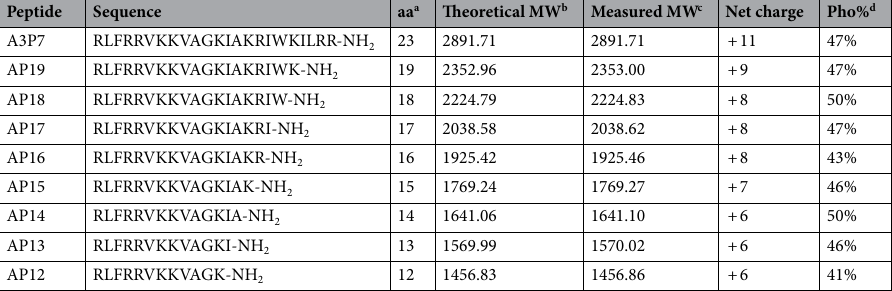
Table 1. Amino acid sequence and physicochemical characteristics of parent peptide and truncated derivatives. a aa, number of amino acids. b MW, molecular weight (g/mol) calculated by the website: https:// pepca lc. com/. c MW, molecular weight (g/mol) measured by mass spectroscopy (MS). d Pho%, the percentage of hydrophobic